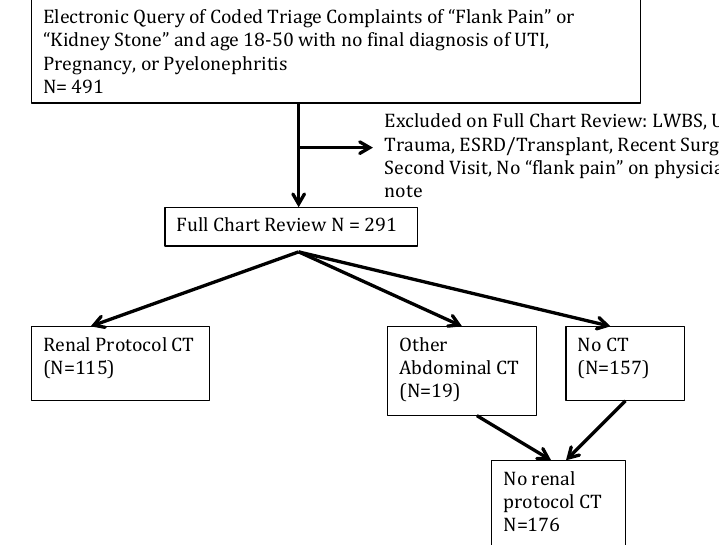
N=176 Figure. Flow of chart inclusion.